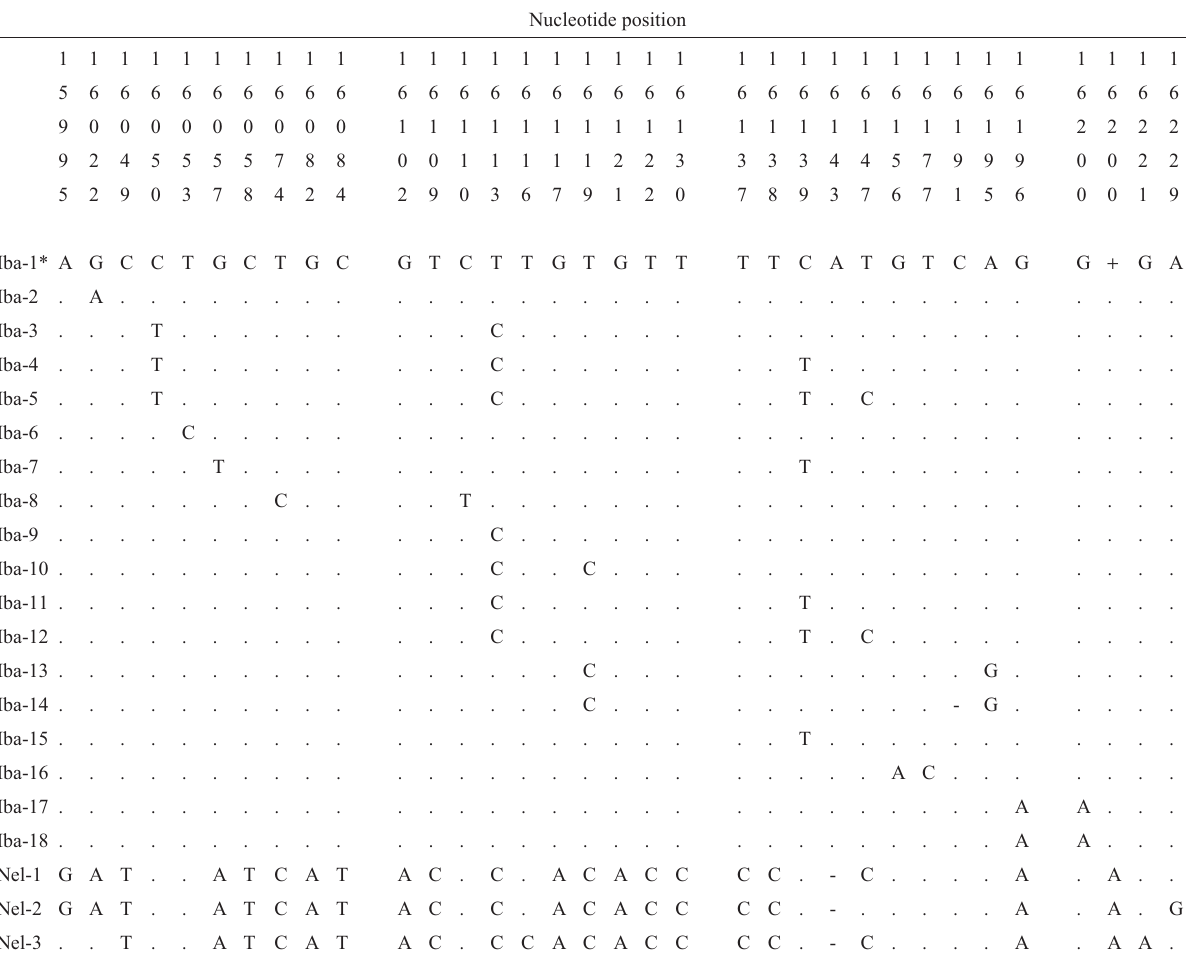
Table 1 - Polymorphic nucleotide sites observed in Brangus-Ibagé and Nellore cows. Only one animal of each haplotypes is presented. Nucleotide